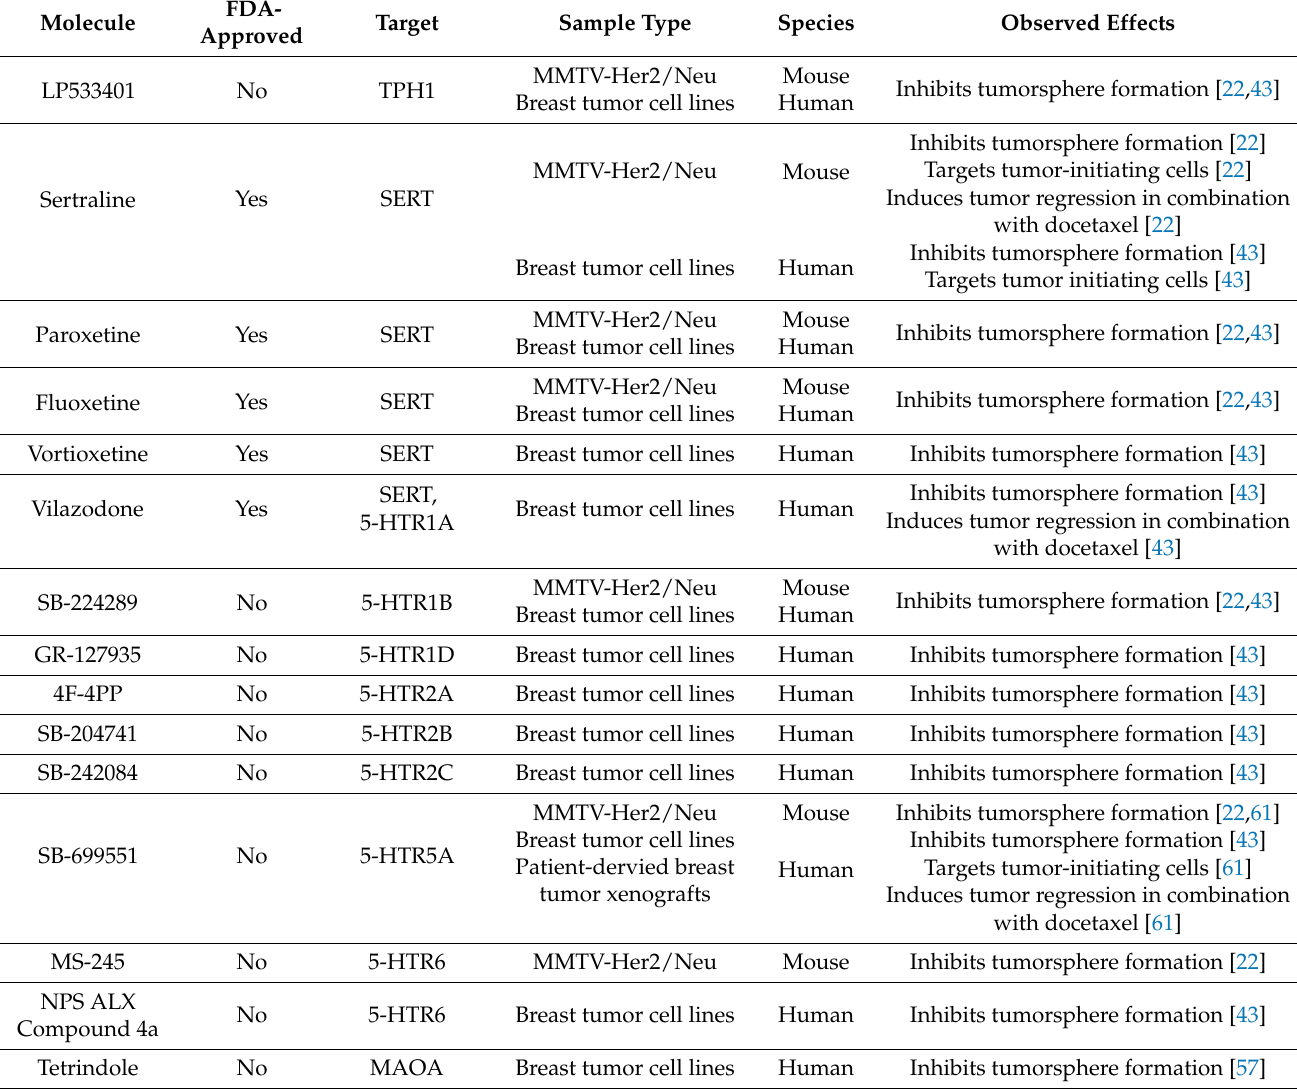
Table 2. Summary of pharmacological